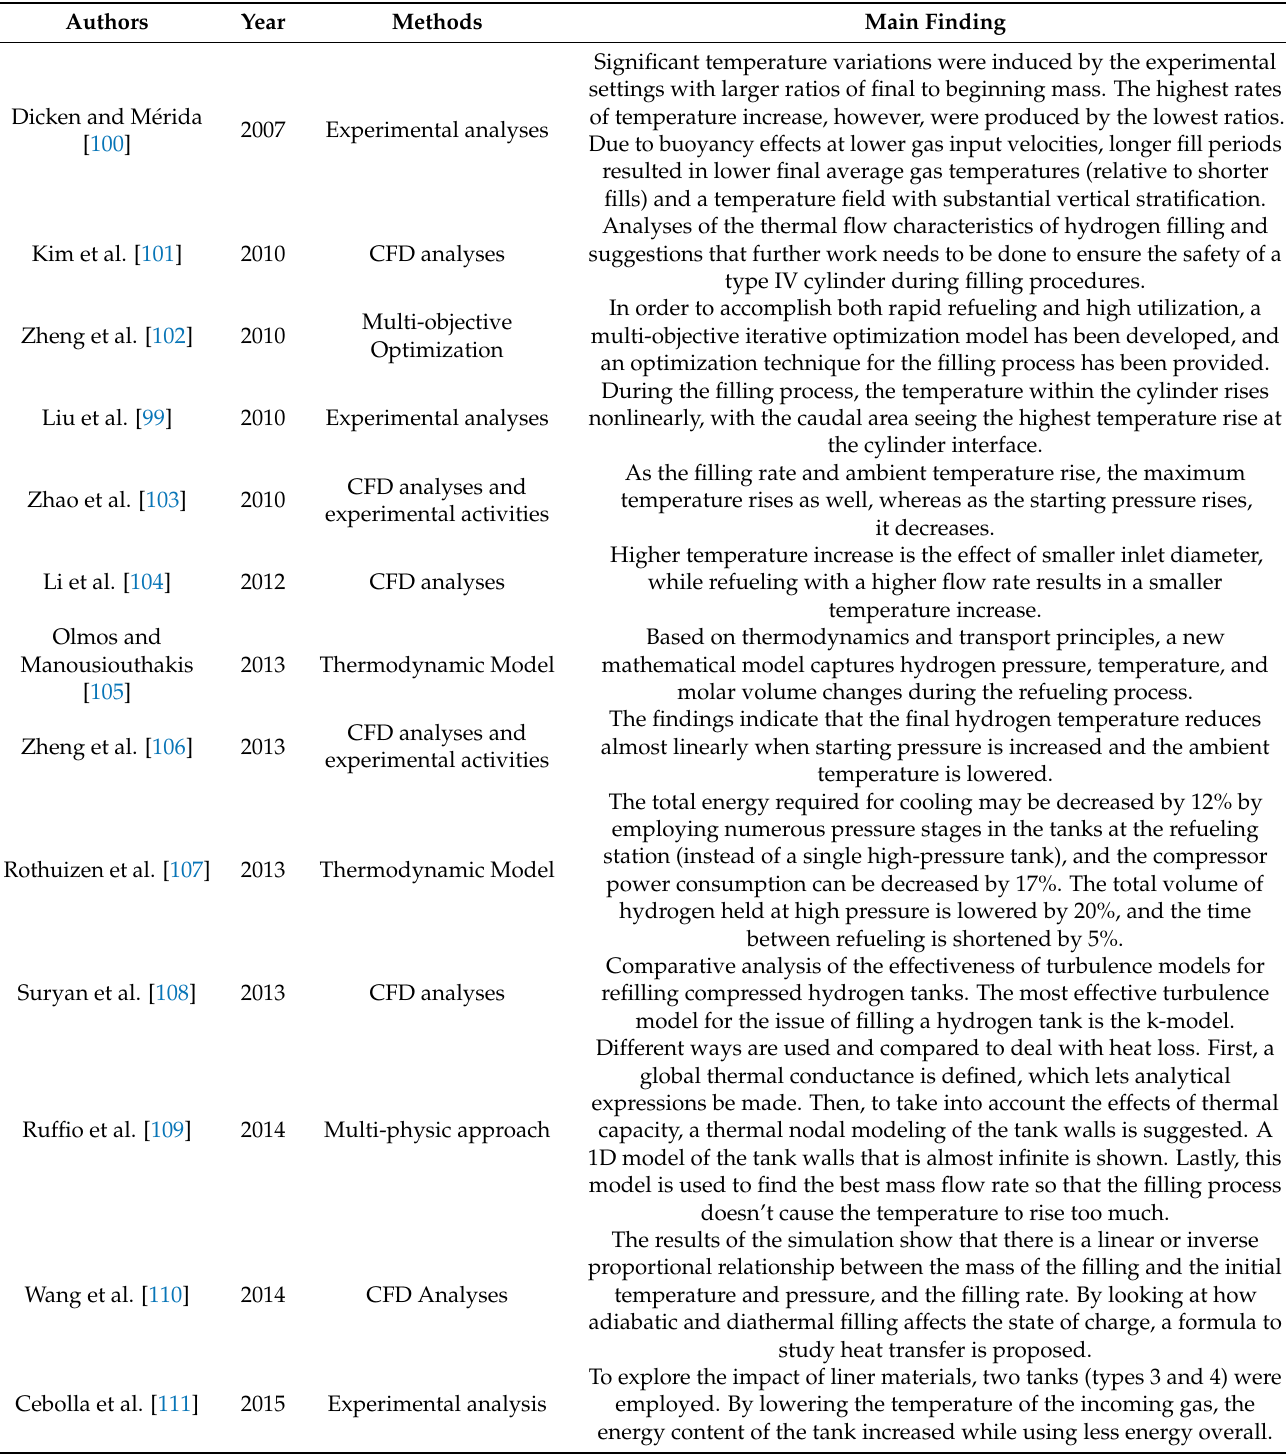
Table 6. Main research activities on CCHS